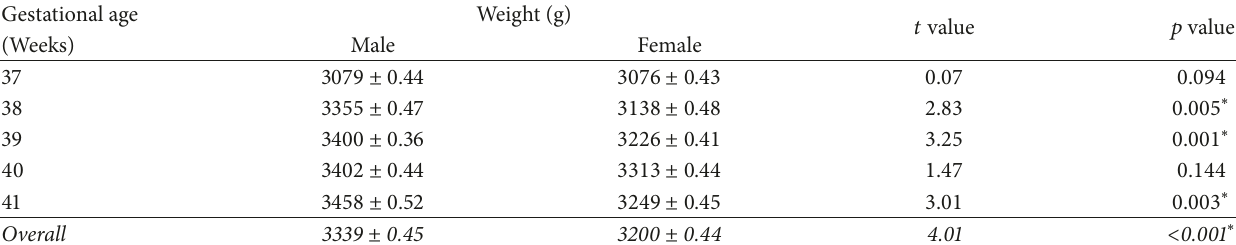
Table 1: Birth weight mean ± SD (g), according to gestational age and